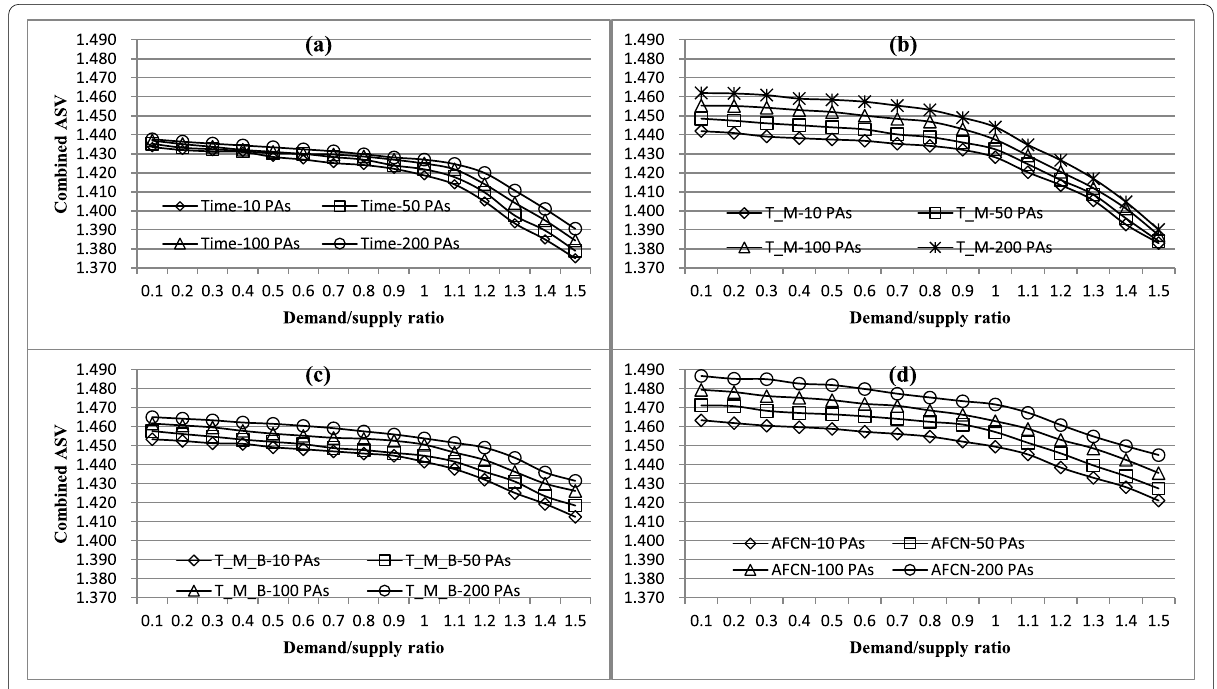
Fig. 13 Average combined ASV for different numbers of PAs